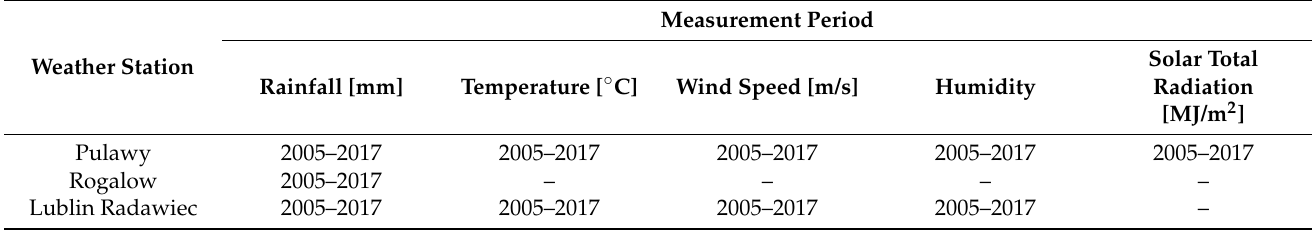
Table 3. Meteorological data for the Bystra river basin (own